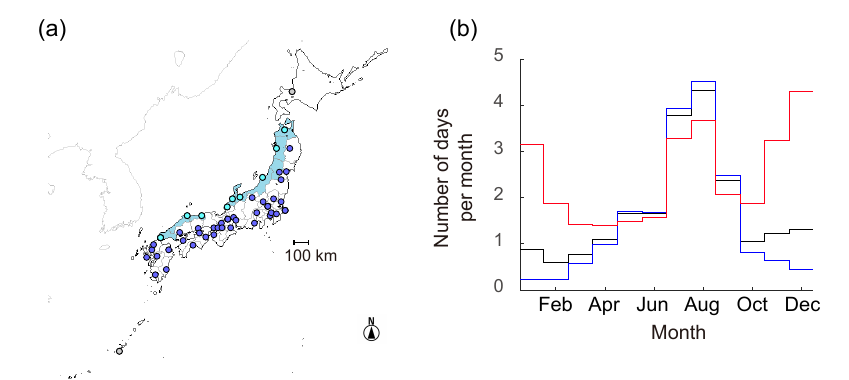
Figure 1. (a) Locations of meteorological stations monitoring lightning activity. Borders between prefectures are shown by thin curves. The area of the Sea of Japan side is indicated by blue shading. Data from Okinawa and Hokkaid¯o stations (gray circles) were excluded from the histogram analysis. (b) Monthly lightning days averaged over the 45 prefectures. The black line indicates the monthly averages for the 45 prefectures, the red line is for the 10 prefectures at the Sea of Japan side, and the blue line is for the rest of the